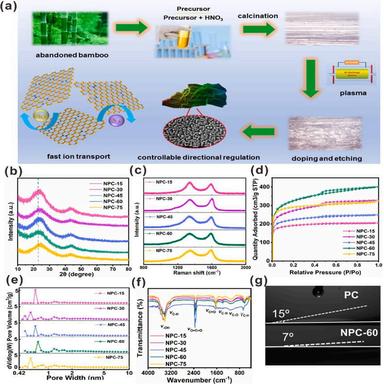
a) Schematic illustration for the fabrication of NPCs and NHCs. b) XRD patterns, c) Raman spectra, d) N2 adsorption-desorption isotherm, e) pore size distribution, and f) FTIR spectra of NPCs. g) Contact angles of NPC-60 and PC.